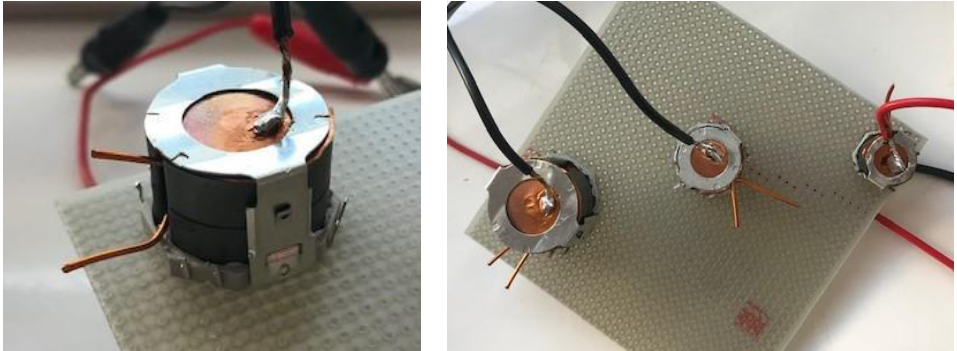
Figure 4. Tested inductors containing cup cores of different dimensions.